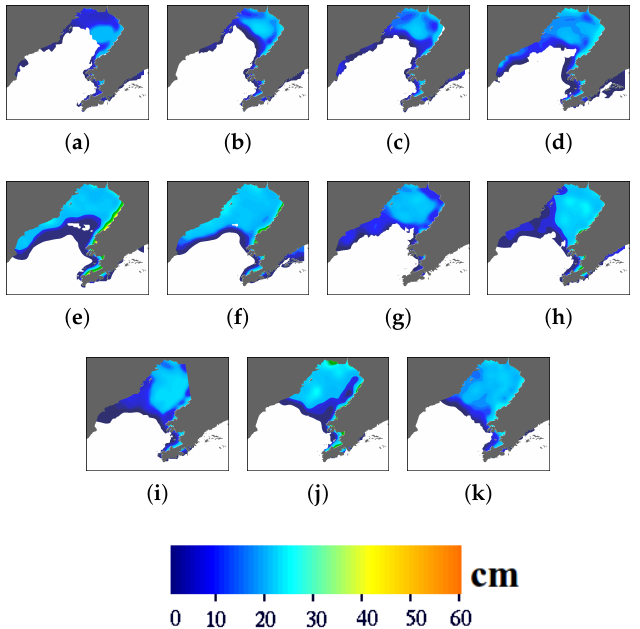
Figure 18. Sea ice thickness background field based on the HIGHTSI model and AMSR2 radiometer data: ( a ) 2 january 2013; ( b ) 6 January 2013; ( c ) 9 January 2013; ( d ) 16 January 2013; ( e ) 23 January 2013; ( f ) 26 January 2013; ( g ) 2 February 2013; ( h ) 9 February 2013; ( i ) 12 February 2013; ( j ) 16 February 2013; ( k ) 19 February